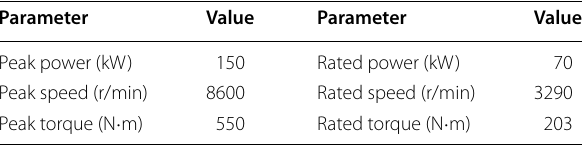
Table 1 Parameters of the on-board electric motor Parameter